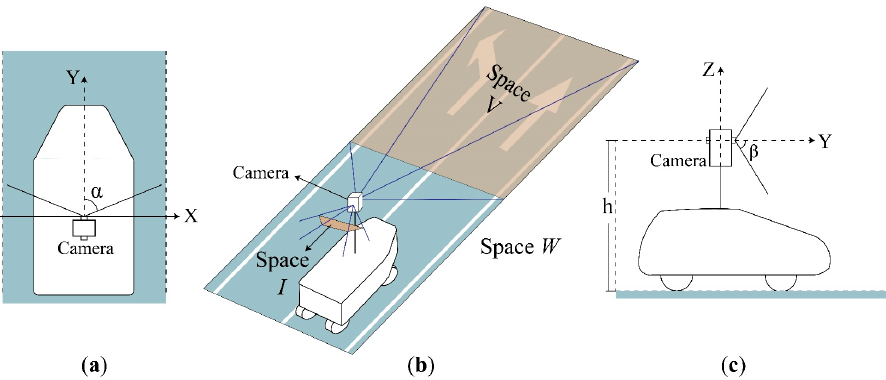
Figure 4. Schematic diagram of process of inverse perspective mapping. ( a ) The XY plane in the W space, i.e., the top view of the vehicle-mounted camera; ( b ) the schematic diagram of the three defined spaces and the camera position in the W space; ( c ) the YZ plane in the W space, i.e., the side view of the vehicle-mounted camera.